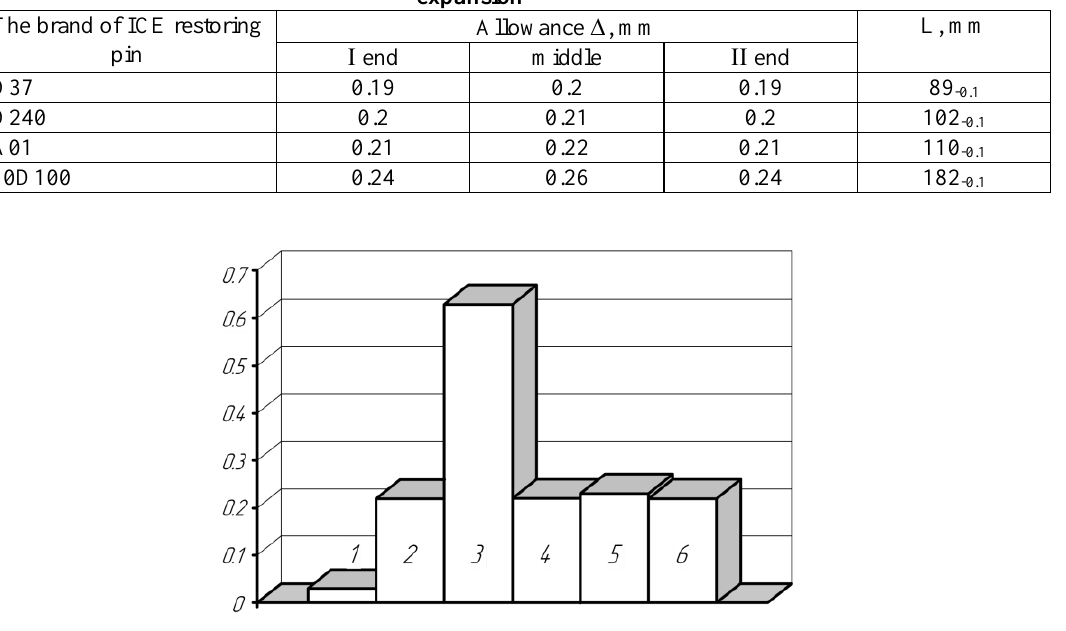
Fig. 4. Histogram of the allowance change for the pin A01 length when processing a batch of pins in production conditions in the amount of 100 pcs.: 1, 3, 4, 6 – allowance value on the edge areas of the processed pin;